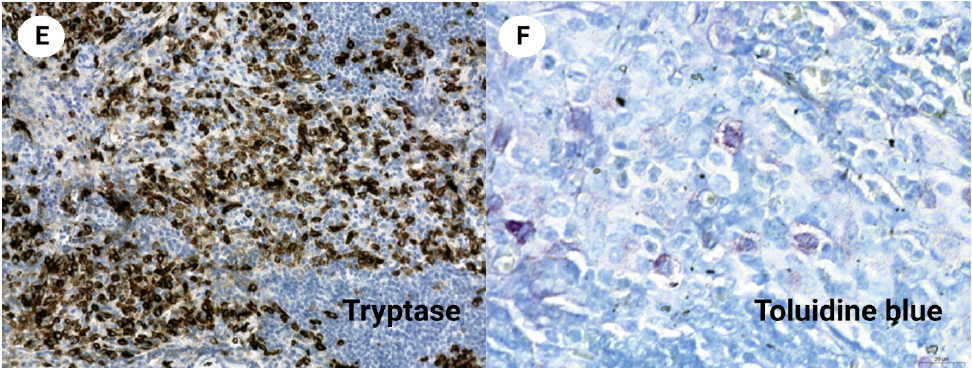
Figure 1. The lymph node demonstrates an interfollicular and sinusoidal proliferation of pale oval cells and abundant eosinophilic aggregates ( A , H&E stain, × 20). It has a granuloma-like pattern with delicate sclerosis ( B , H&E stain, × 200) and eosinophilic microabscesses ( C , H&E stain, × 100). The neoplastic cells have medium-sized with clear or pinking moderate cytoplasm. The nucleus of some cells shows a vesicular nuclear membrane and distinguishable nucleoli ( D , H&E stain, × 630). The neoplastic cells are confirmed as mast cells expressing tryptase ( E , × 200) and having basophilic cytoplasmic granules ( F , toluidine blue stain, × 630).